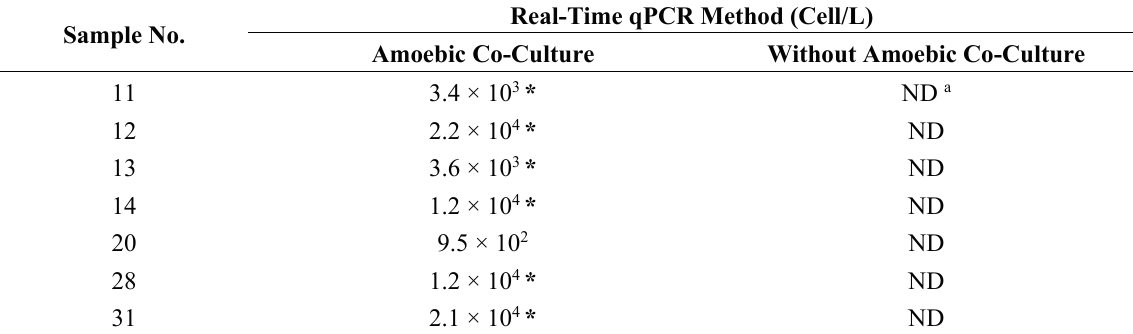
Table 3. Results of the real-time qPCR in the culture-negative 26 samples other than the 31 samples shown in Table 2. Sample